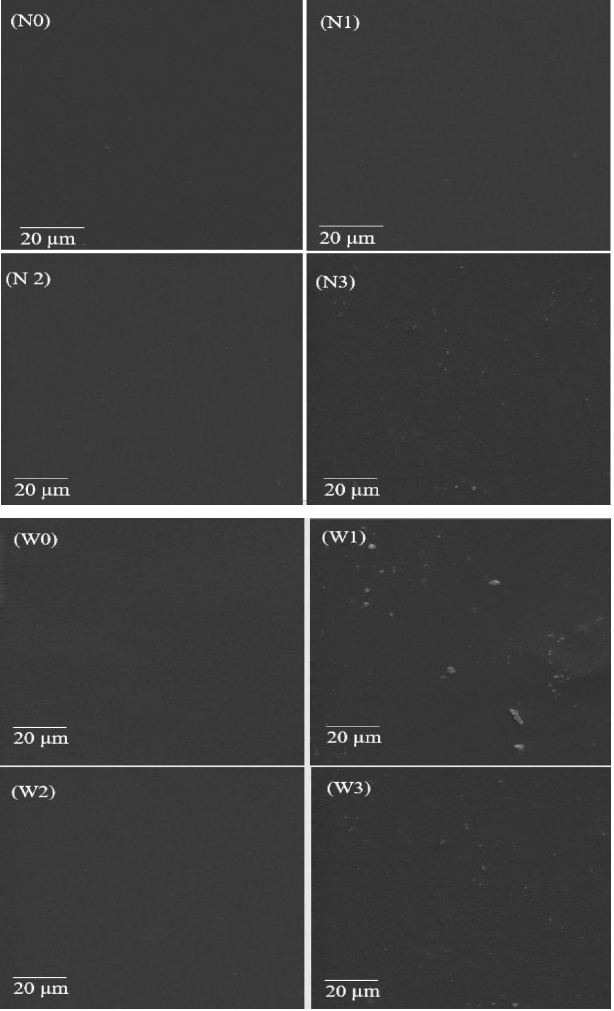
Figure 1. Morphological analysis of the films. Note: N0 = regular starch film with 0% nanocellulose; N1 = regular starch film with 0.5% nanocellulose; N2 = regular starch film with 1% nanocellulose; N3 = regular starch film with 1.5% nanocellulose, W0 = waxy starch film with 0% nanocellulose; W1 = waxy starch film with 0.5% nanocellulose; W2 = waxy starch film with 1% nanocellulose; W3 = waxy starch film with 1.5%